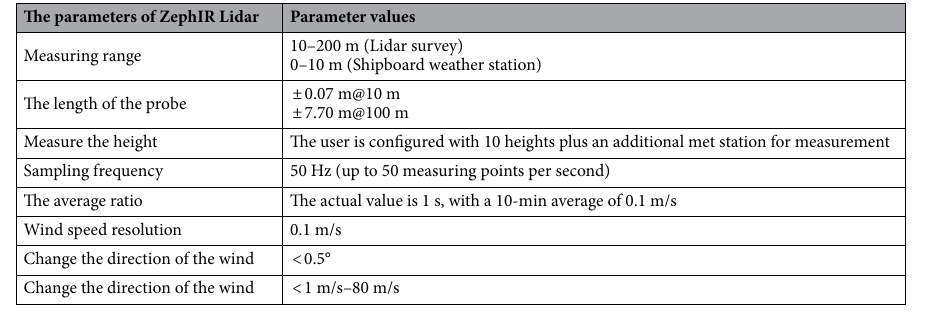
Table 2. Main parameters of ZephIR Lidar.